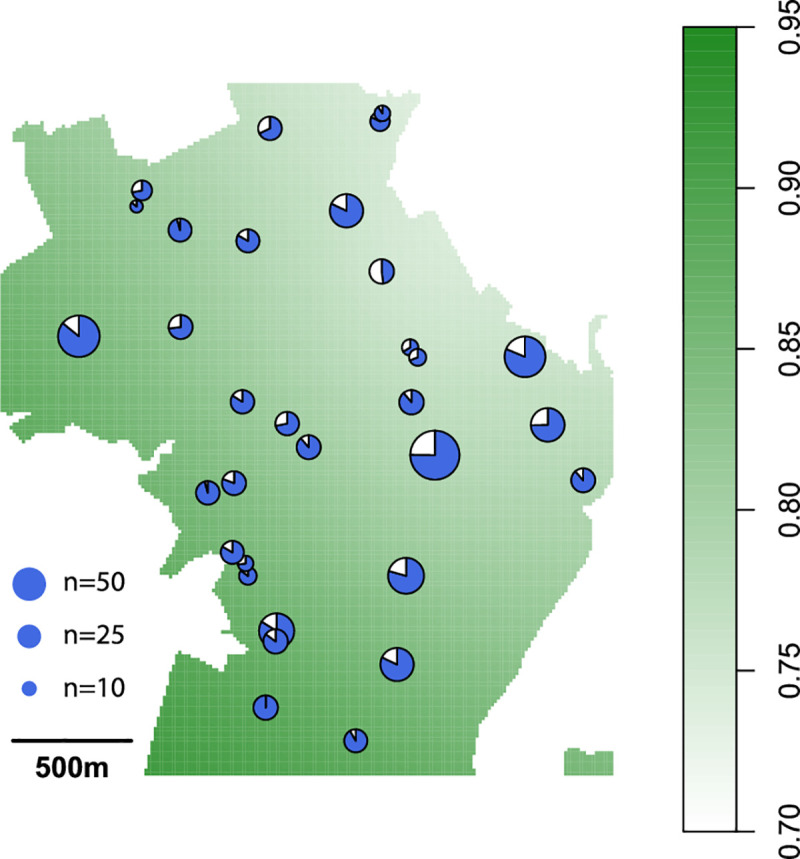
Heatmap showing locations and seropositivity of sampled urban blocks.